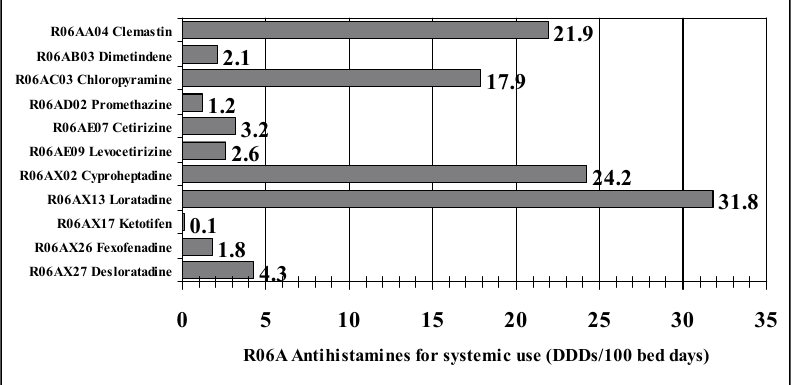
Figure 3. Utilization of specific preparations belonging to the group “R06 Antihistamines for systemic use” as number of DDDs/100 hospital bed